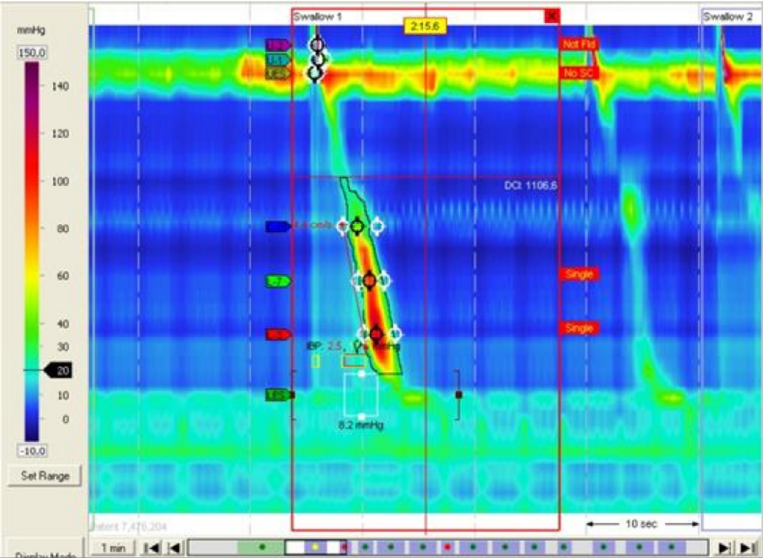
Figure 1. HRM recording in a patient with a hiatus hernia with a clear separation observed between LOS and the crura of the diaphragm.